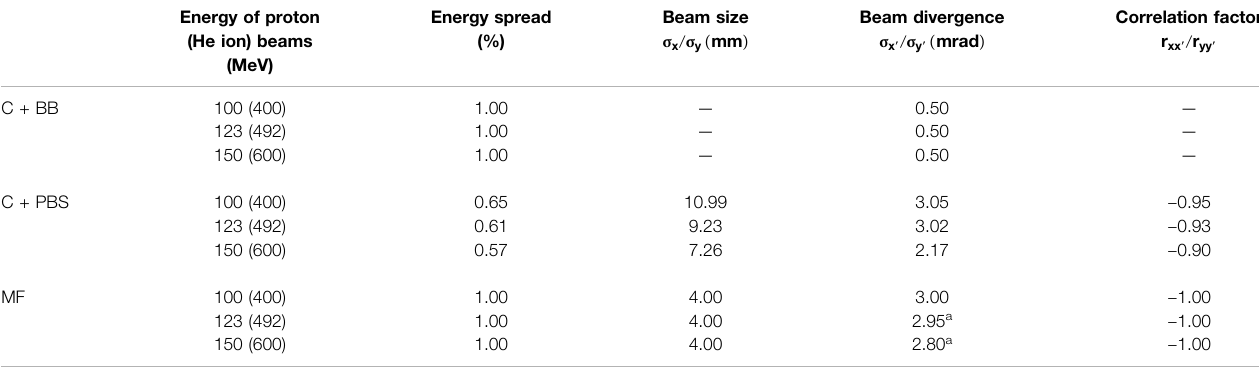
TABLE 2 | Beam source parameters used for protons and helium ions. The energy ofthe helium ion beams (values in parantheses) was four times that ofthe proton beams.